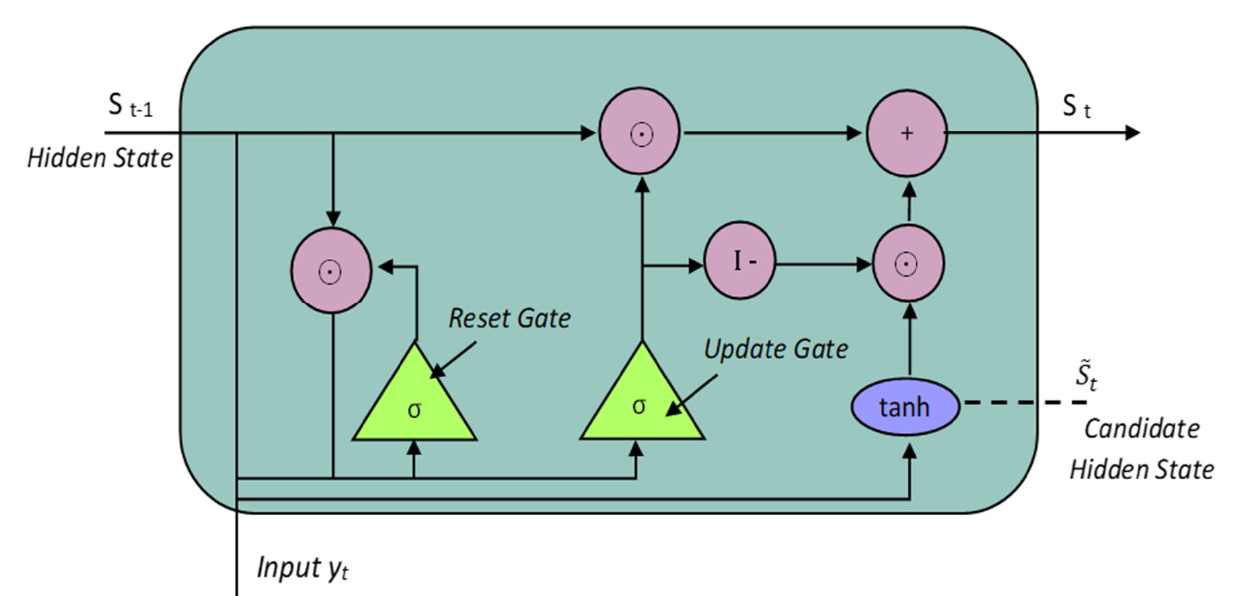
Figure 3. GRU architecture.